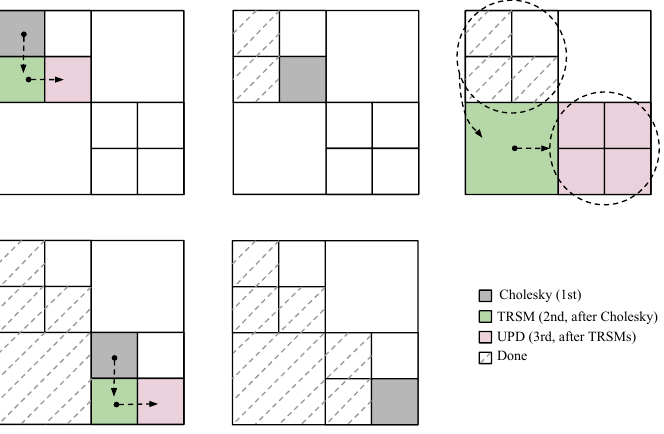
Fig. 4 Operations and data dependencies in the generalization of the BRL algorithm for the H -Cholesky